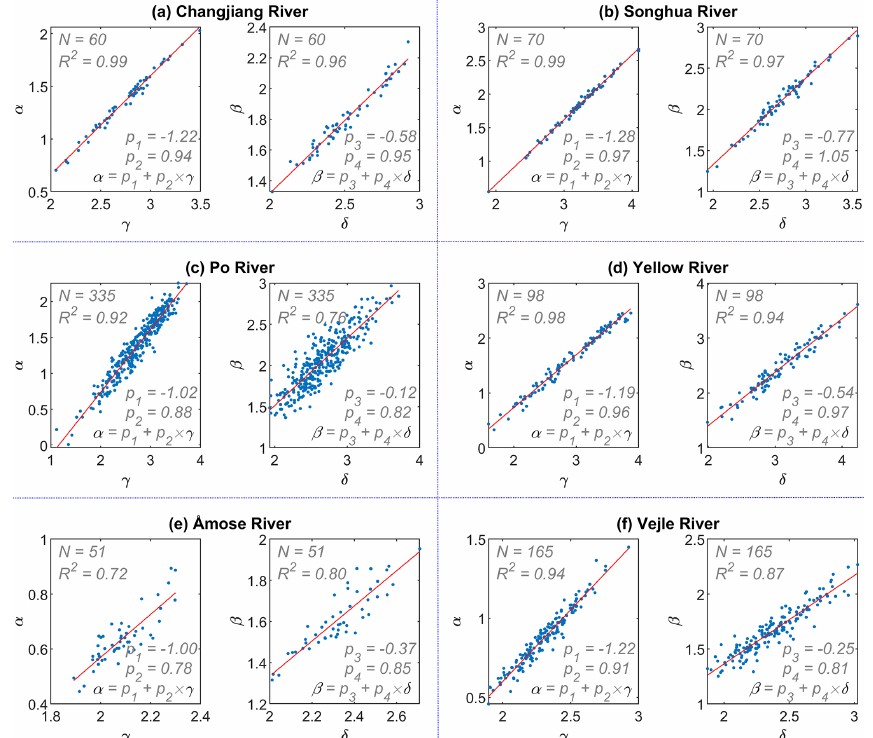
Figure A4. Linear relationships between γ – α and δ – β for six rivers. Randomly generated Manning’s coefficient in the range of 0.015– 0.05 for each cross-section was used to calculate conveyance. The number of cross-sections, coefficient of determination, and regression coefficients are labeled in each